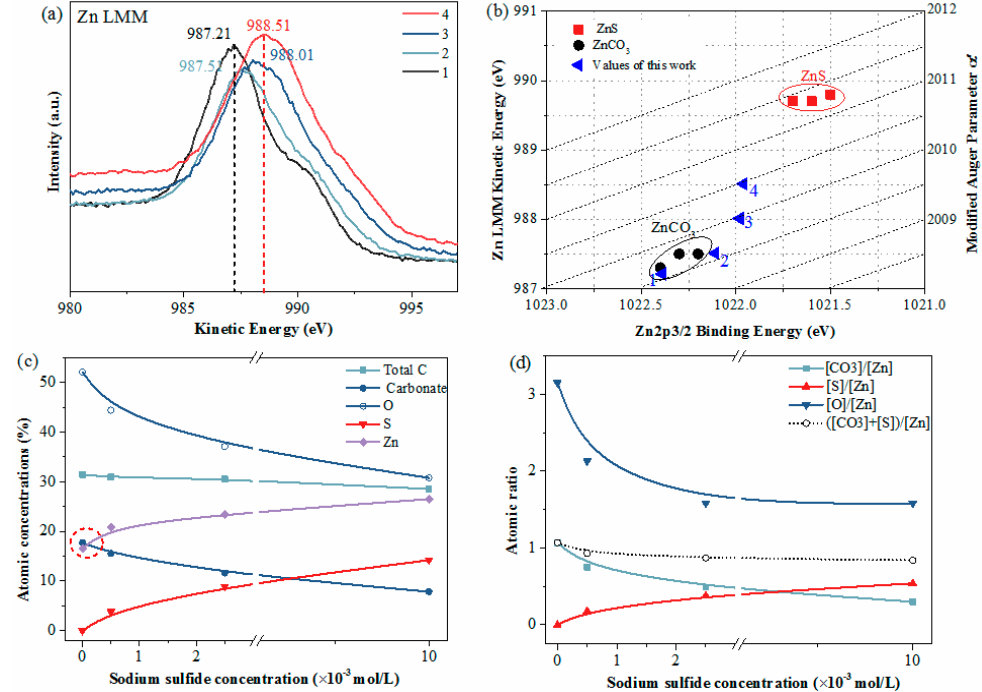
Figure 6. XPS Zn LMM spectra ( a ) and modified Auger parameter plot of Zn data ( b ) of smithsonite samples treated with (1) 0, (2) 0.5 × 10 − 3 , (3) 2.5 × 10 − 3 and (4) 10 × 10 − 3 mol / L Na 2 S · 9H 2 O. Atomic concentration ( c ) and atomic ration ( d ) of smithsonite as a function of Na 2 S ⋅ 9H 2 O.